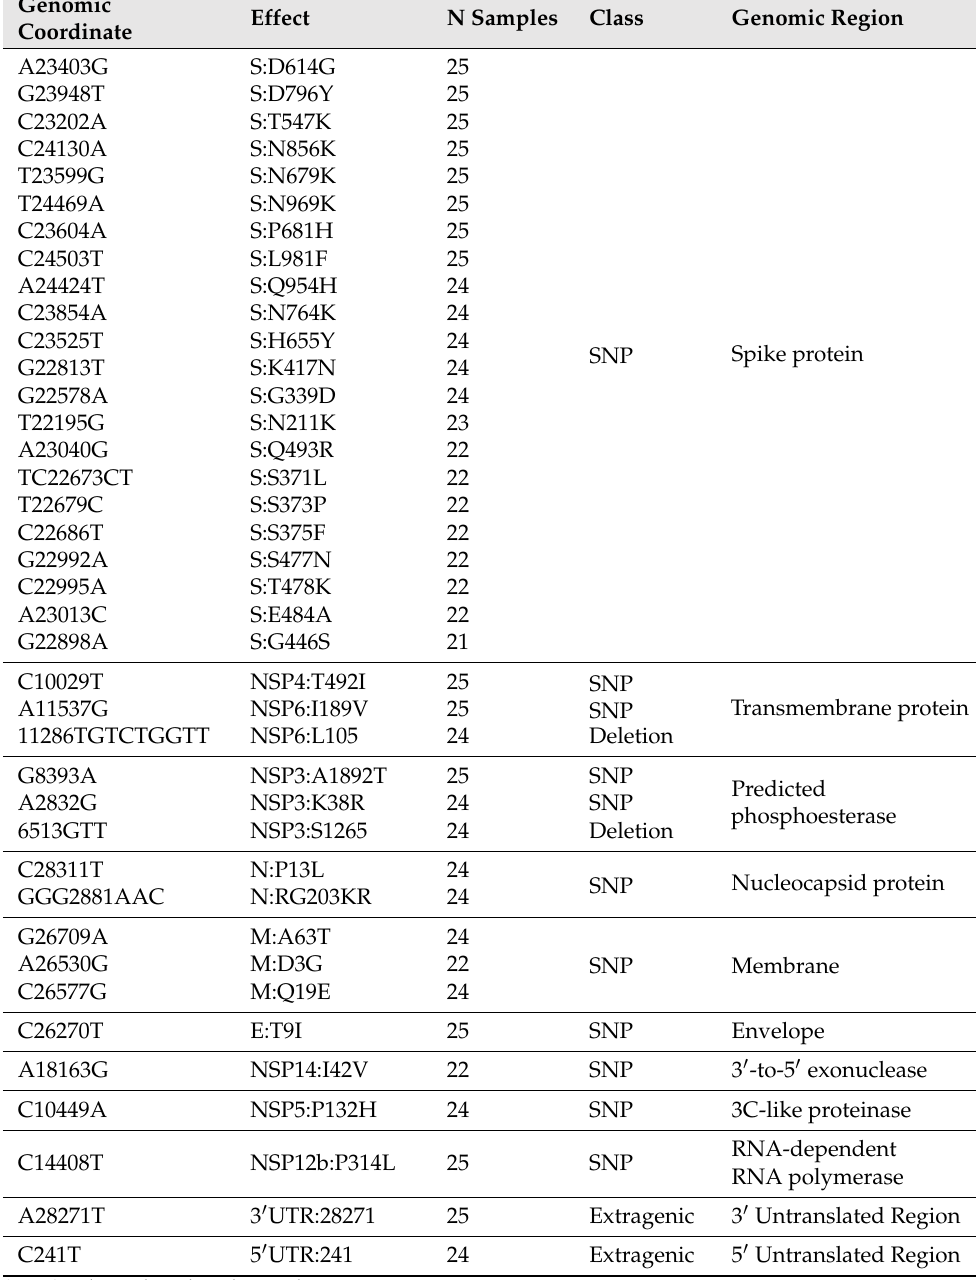
Table 2. The frequent mutation events observed in Omicron SARS-CoV-2 genomes. Genomic